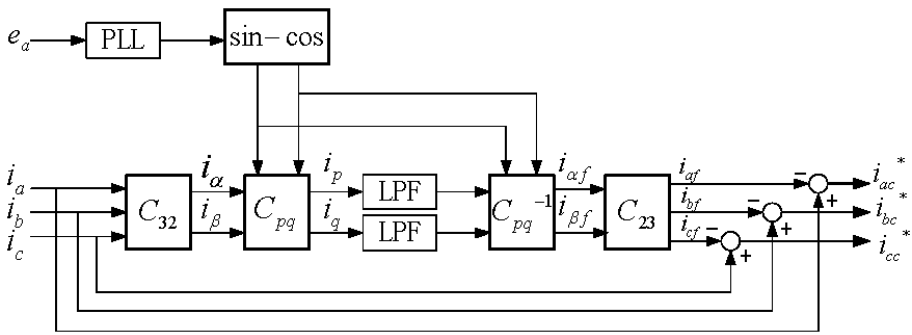
Figure 3. i p – i q based harmonic detection method schematic.